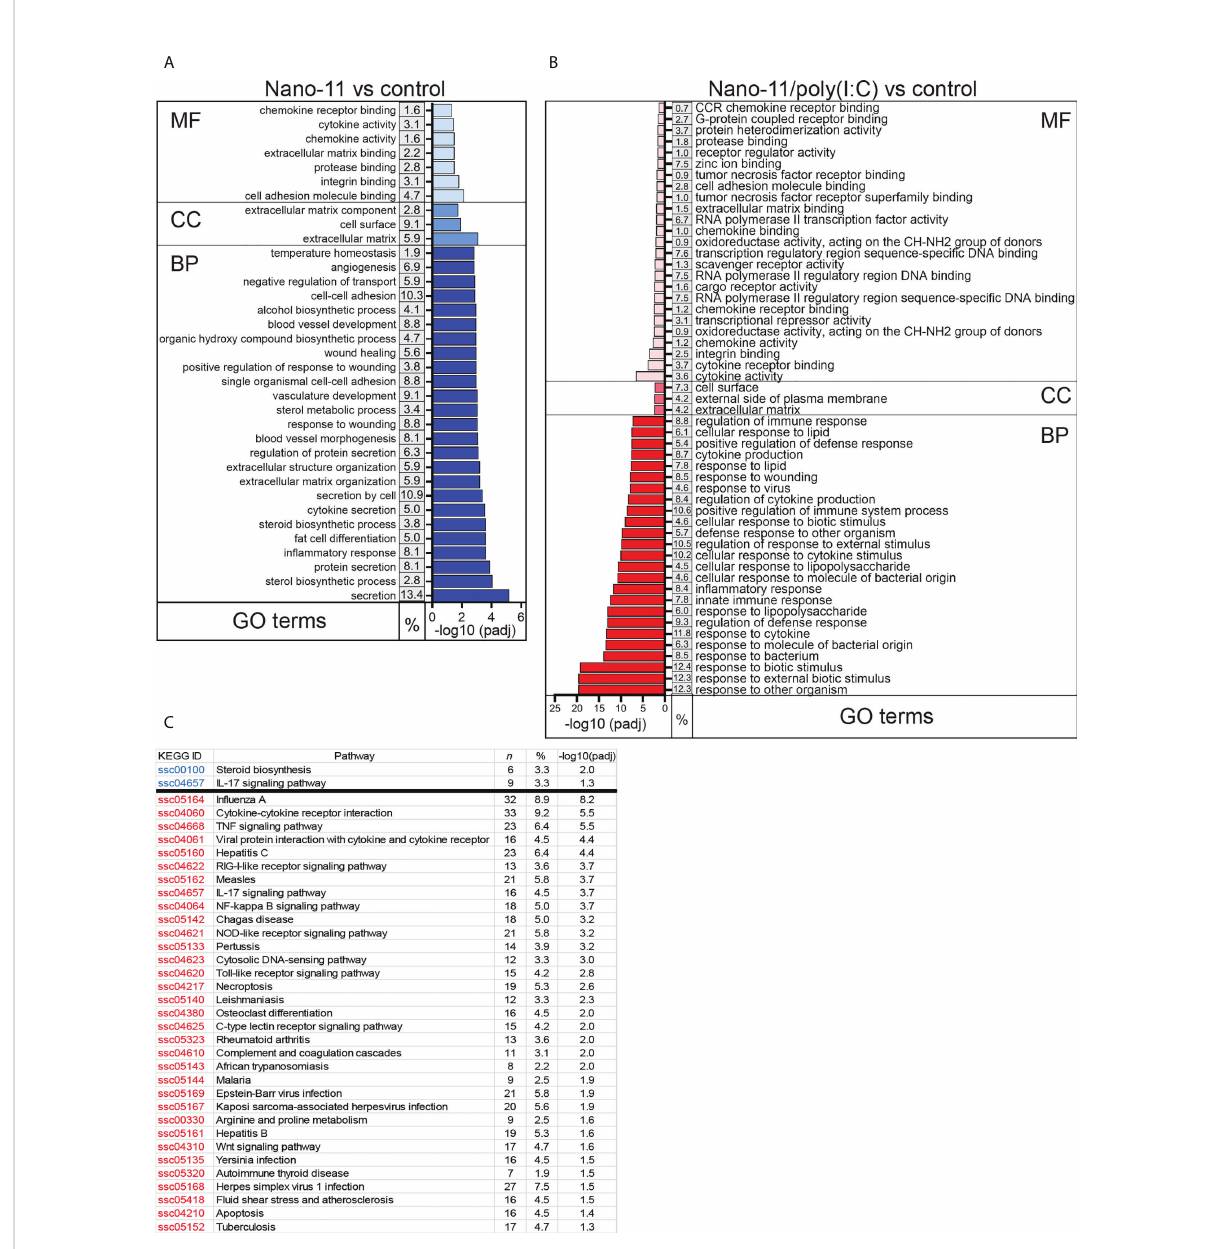
FIGURE 3 Gene ontology (GO) and KEGG pathways with the highest enrichment of differentially expressed genes (DEGs) between Nano-11 or Nano-11/ poly(I:C) stimulated and untreated porcine Mo-DCs. (A, B) GO enrichment analysis of the DEGs following stimulation with Nano-11 (A) or Nano- 11/poly(I:C)in comparison to untreated porcine Mo-DCs. Biological process (BP), cellular component (CC), and molecular function (MF) are GO categories. The top 25 GO terms are shown for the Nano-11 BP category and the Nano-11/poly(I:C) MF and BP categories. (C) KEGG pathway analysis with adjusted p-values (padj < 0.05). Signi fi cant pathways for Nano-11 are written in blue font and for Nano-11/poly(I:C) in red font. The derived P values were adjusted with the Benjamini and Hochberg method for controlling the false discovery rate by implementing the clusterPro fi ler R package. The gene ratio is the percentage (%) of the total number of DEGs between the GO categories or KEGG pathways and all of the DEGs listed in the GO or KEGG databases; n, the total number of DEGs that contributed to the